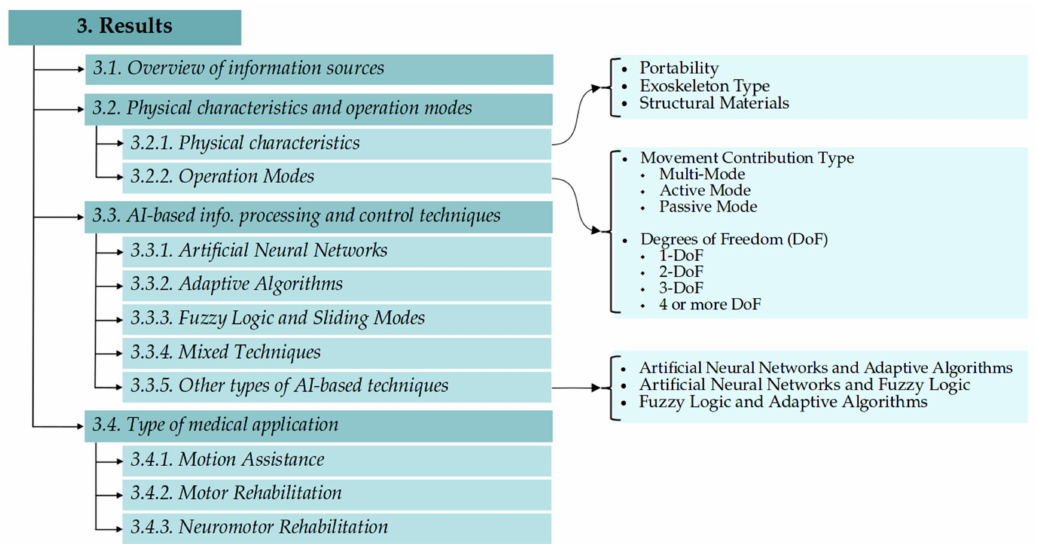
Figure 3. Hierarchical grouping map for the elements taken into account within the review, as set out in the following sub-sections.